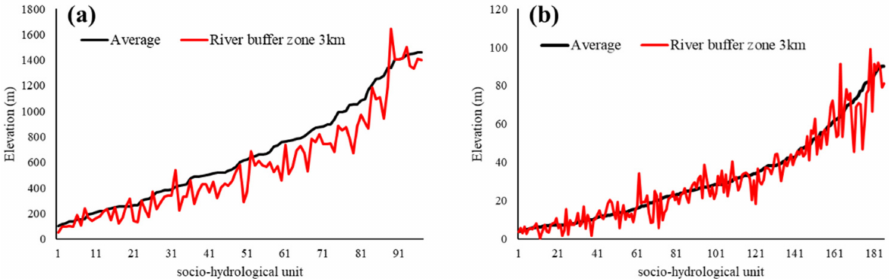
Figure 10. Comparison of river buffer elevation and average elevation of all socio-hydrological units: ( a ) mountain area; ( b ) plain